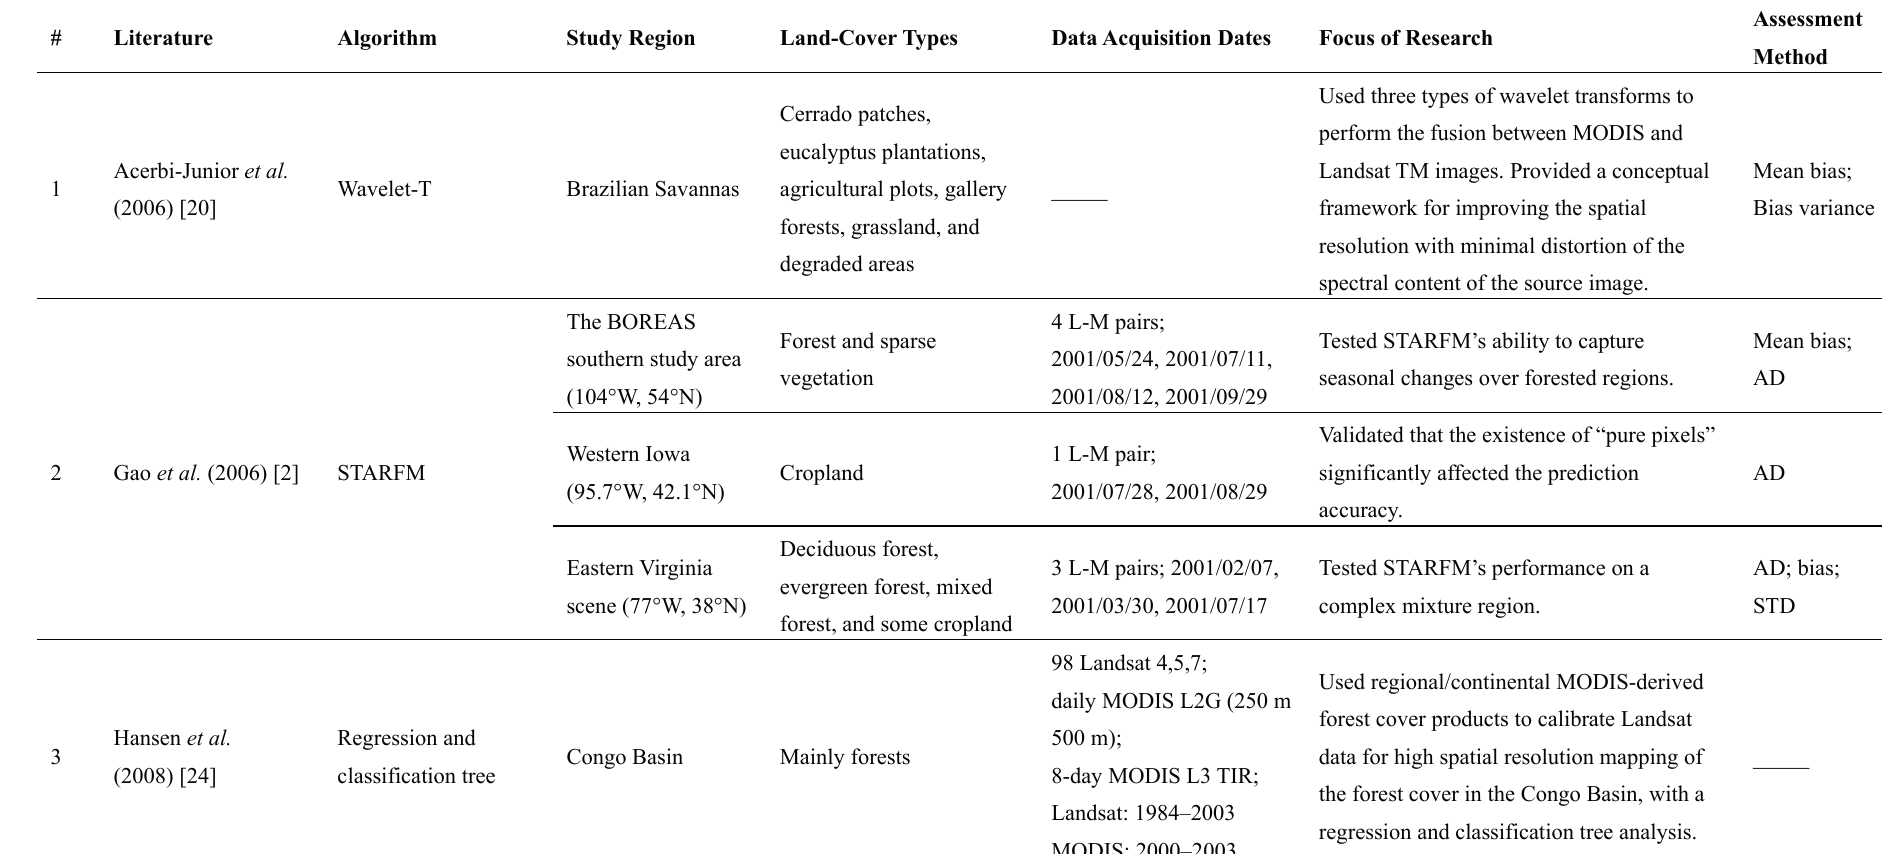
Table A1. A summary of spatiotemporal fusion applications and relevant